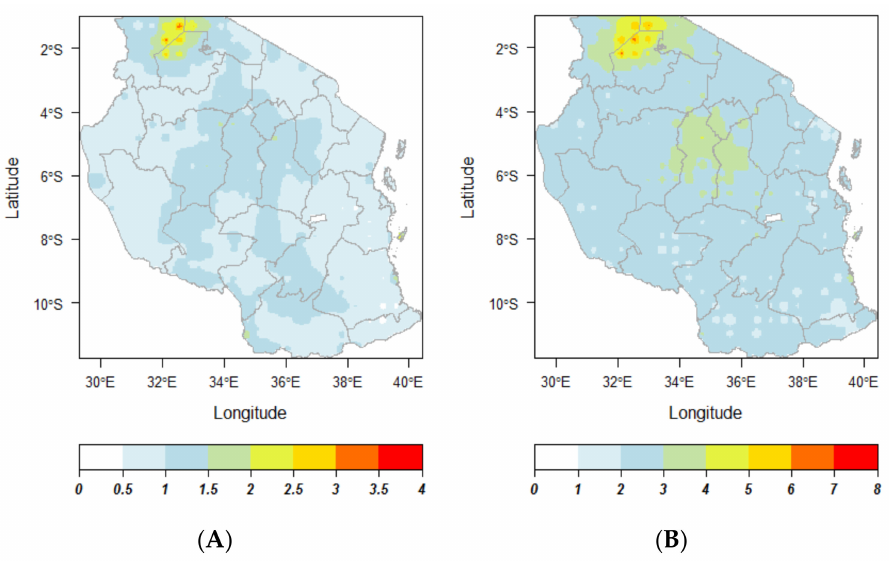
Figure 1. Heatwave climatology over Tanzania, from 1983 to 2012: ( A ) heatwave magnitude index daily (HWMId) and ( B ) heatwave duration (HWD).